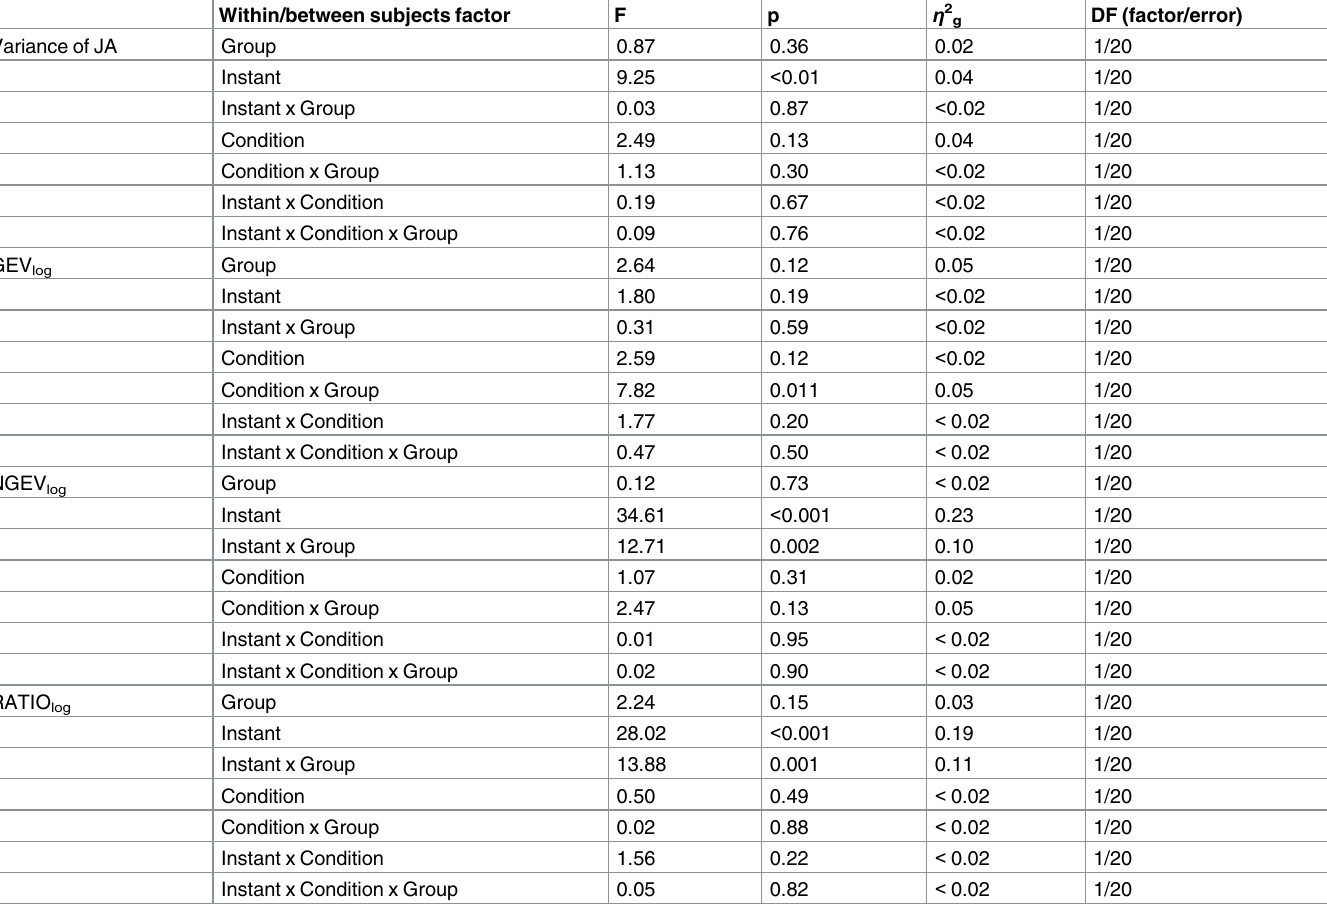
Table 3. Summaryof ANOVA results on varianceof joint angles (JA), GEV log , NGEV log , and RATIO log with factors Group (control and experimen- tal), Instant (at the obstacle and at the end of movement), and Condition (pretest and posttest). Within/between subjects